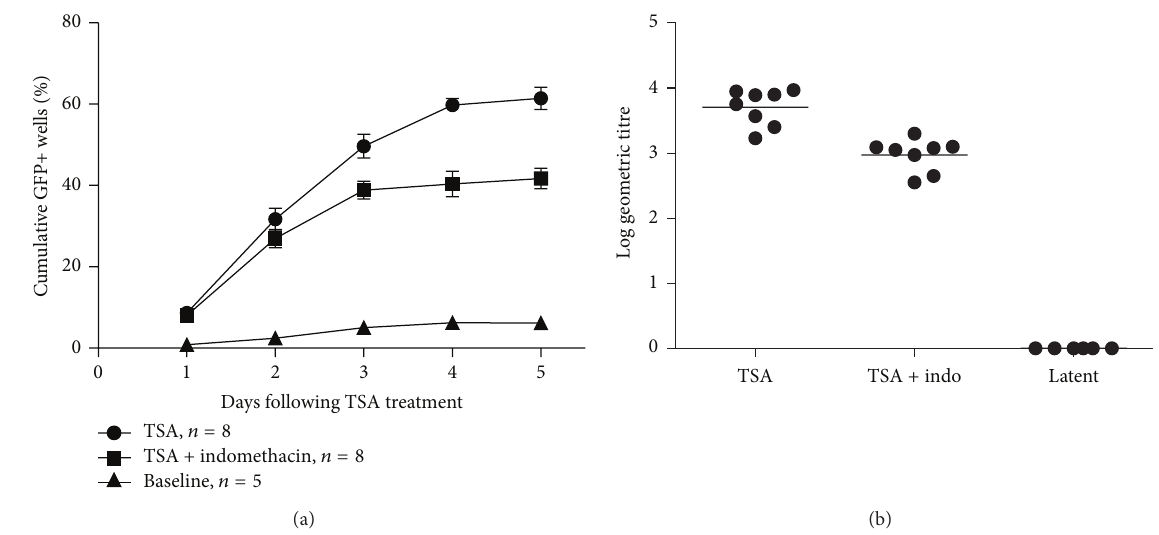
Figure 6: Effects of indomethacin on reactivation of HSV-1. (a) HSV1 reactivation was measured by the cumulative percentage of GFP- positive wells using fluorescence microscopy. Black triangles = baseline reactivation; black circles = TSA-treated; black squares = TSA- and indomethacin-treated. Error bars = standard error of the mean. (b) HSV-1 titer measured by TCID50 on media from latently infected (latent), latently infected TSA-treated (TSA), and latently infected TSA- and indomethacin-treated (TSA + indo) cultures. Viral titer = 0.7 TCID50. The Y -axis represents the log geometric